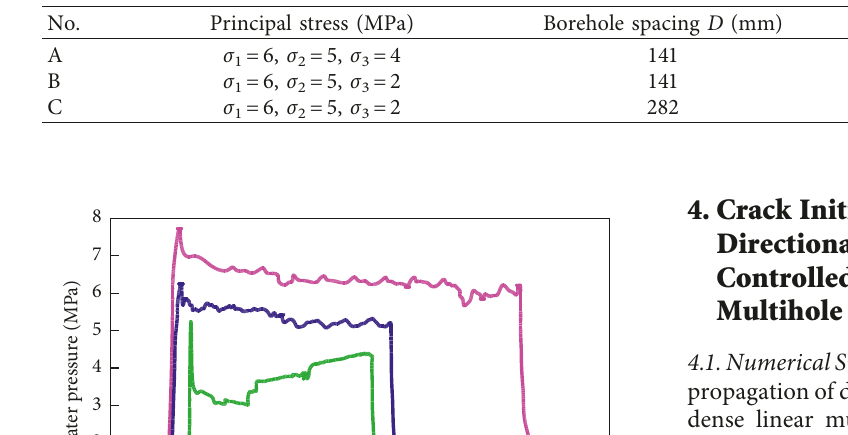
Table 2: Experimental scheme.